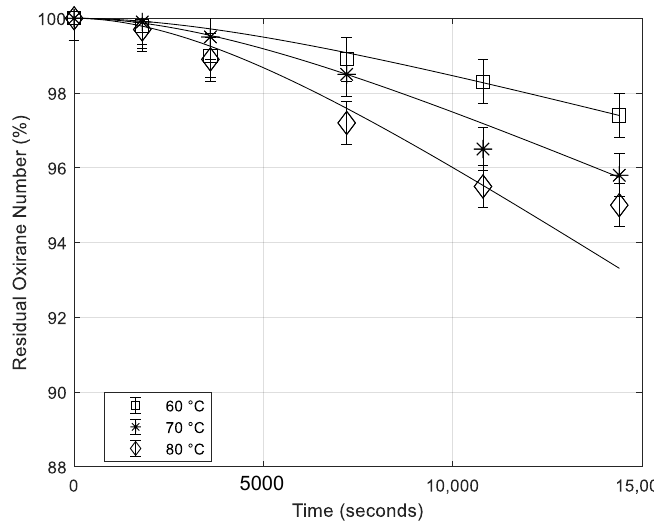
Figure 7. Residual oxirane number profiles for different temperatures. All the other conditions are the same (mass of catalyst 0.65 g; rate of agitation 500 rpm; mass of formic acid 5.16 g). Points are experimental data lines that are calculated with the developed model.